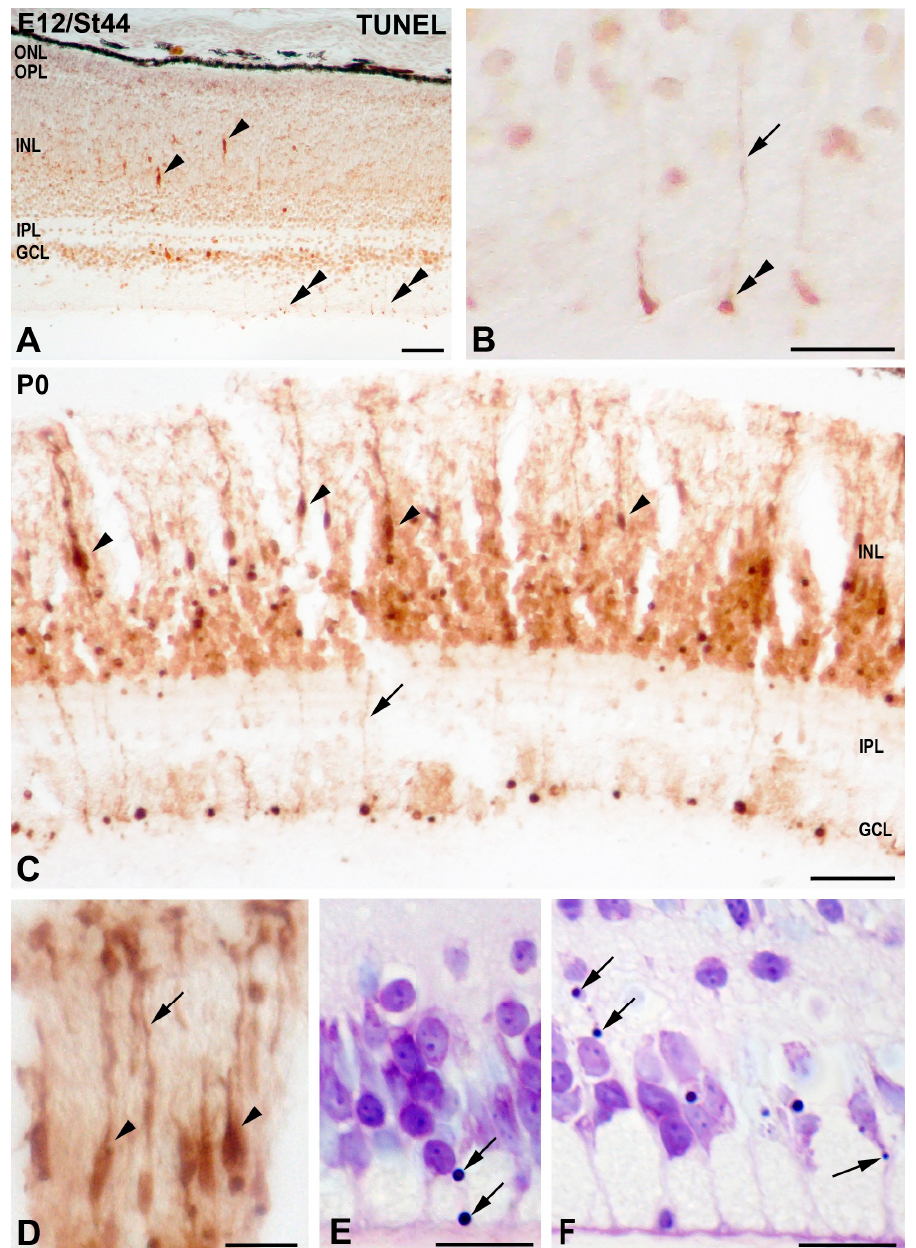
Figure 7. Spatial distribution of TUNEL-positive elements in the developing retina of T. guttata . Retinal cryosections of embryos (St44: ( A , B )) and newly hatched chicks (P0: ( C , D )) were treated in accordance with this histochemical technique. Elongated cell somata located in the INL (arrowheads in ( A , C , D )) and fine processes (arrows in ( B – E )) of radially oriented cells were diffusely labeled with this technique. Occasionally, TUNEL-positive Müller cell endfeet were labeled in the vitreal surface of the retina (double arrowheads in ( A , B )). Semi-thin sections treated according to the toluidine blue technique revealed small pyknotic bodies within the cytoplasm of Müller cells (arrows in ( E , F )). Abbreviations: GCL, ganglion cell layer; INL, inner nuclear layer; IPL, inner plexiform layer; ONL, outer nuclear layer; OPL, outer plexiform layer. Scale bars: 50 µ m in ( A , C ); 10 µ m in ( B , D – F